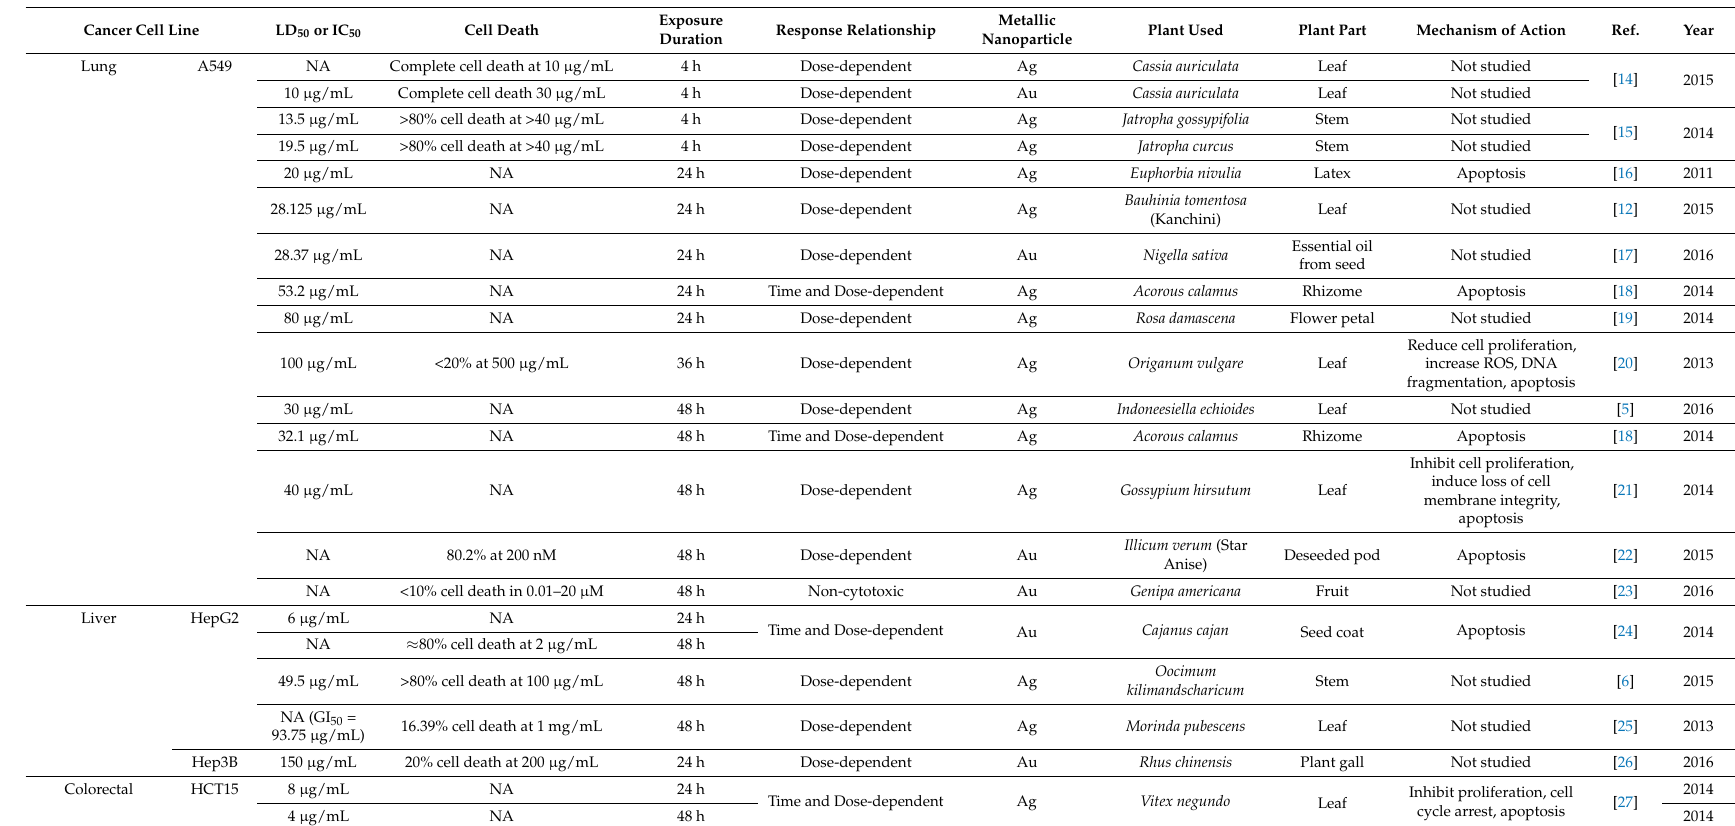
Table 1. The cytotoxicity of the plant-mediated syntheses of metallic nanoparticles on cancer cells (in